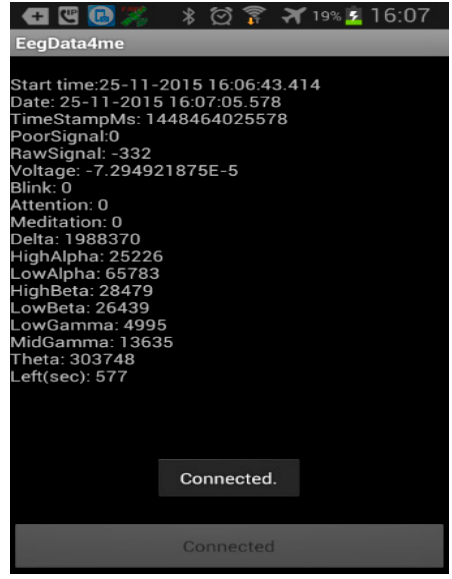
Figure 5. Android application to collect the EEG data.